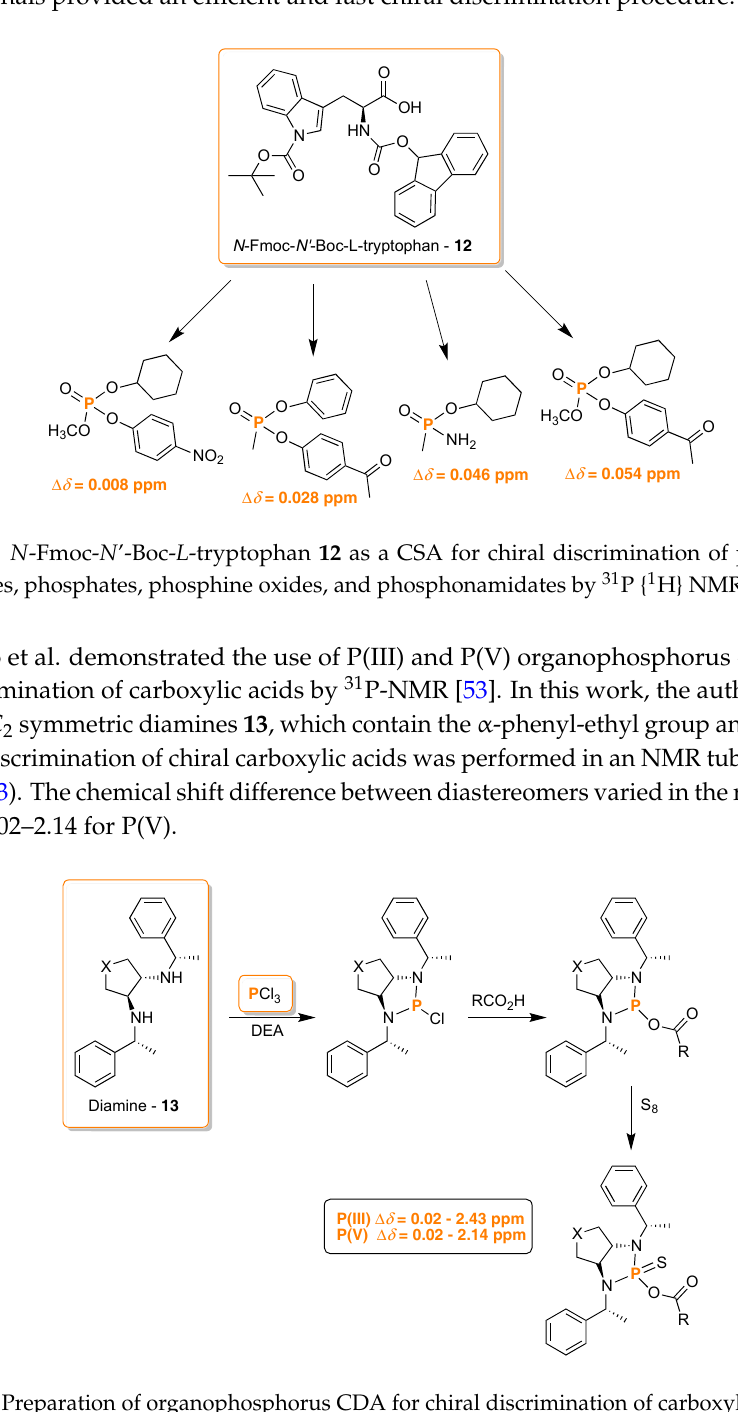
Scheme 13. Preparation of organophosphorus CDA for chiral discrimination of carboxylic acids by 31 P { 1 H} NMR